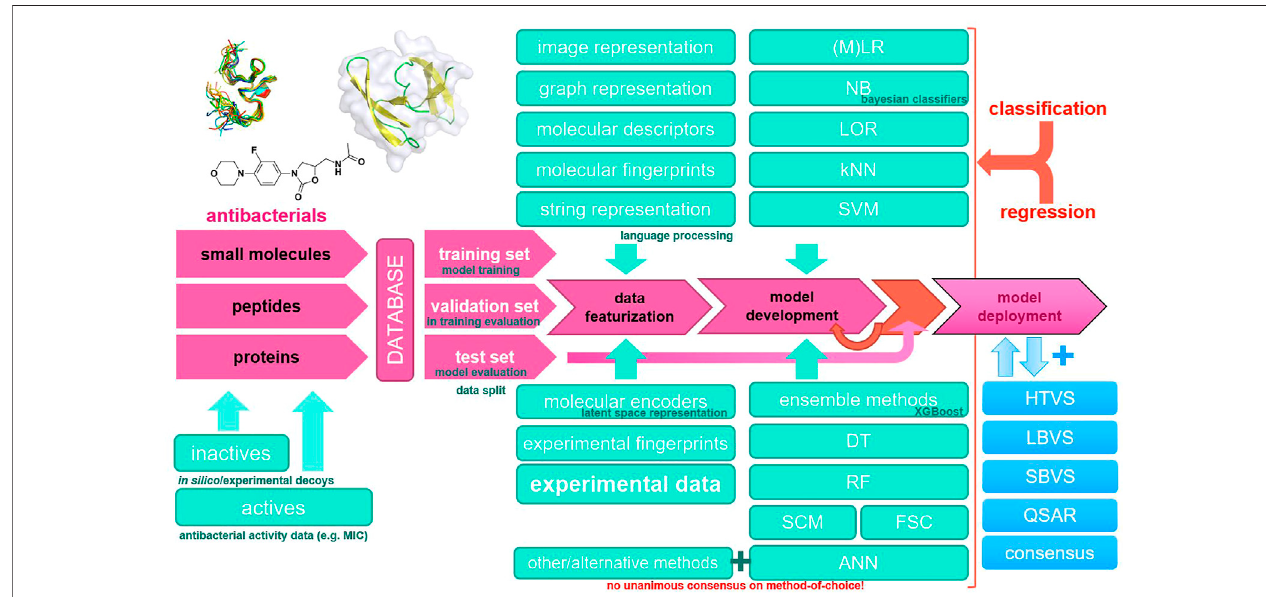
FIGURE1| Commonmachinelearningmethodologyinnovelantibacterialdrugdesignandatypicalmodelingwork fl ow.ANN,arti fi cialneuralnetwork;DT,decision tree;FSC,feedbacksystemcontrol;HTVS,high-throughputvirtualscreening;kNN,k-nearestneighbors;LBVS,ligand-basedvirtualscreening;LOR,logisticregression; (M)LR, (multiple) linear regression; NB, naïve Bayes; QSAR, quantitative structure – activity relationship; RF, random forest; SBVS, structure-based virtual screening; SCM, set covering machine; SVM, support vector machines.